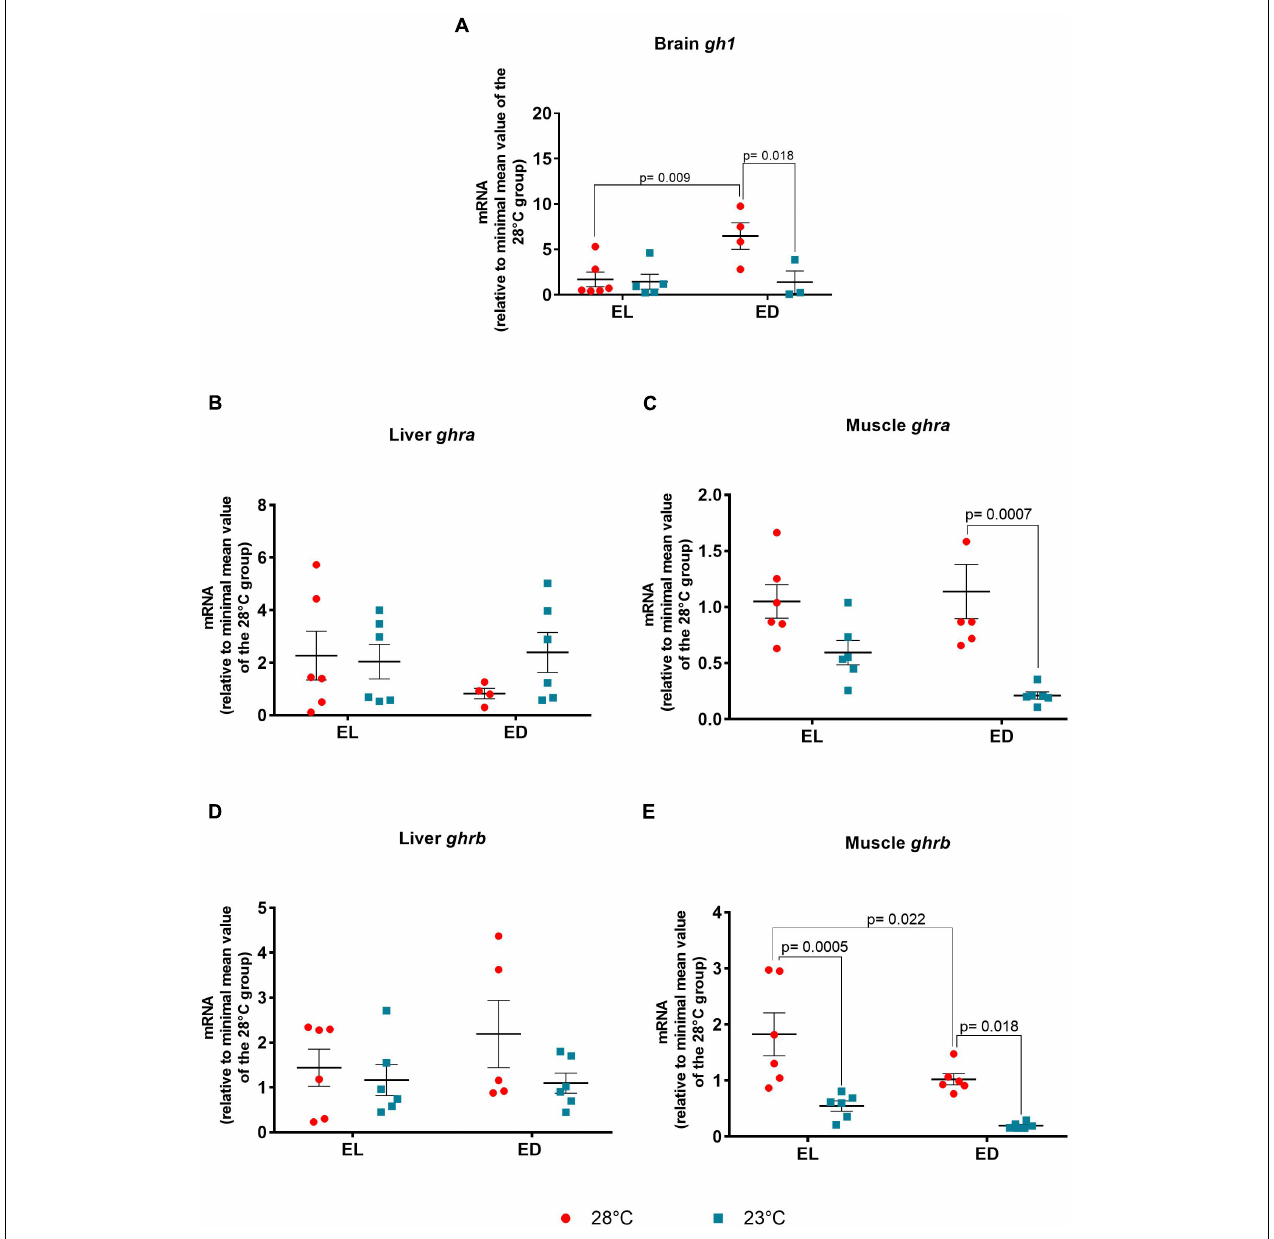
FIGURE 2 | Early light (EL) and early dark (ED) gene expression of growth hormone ( gh1 ) and growth hormone receptors ( ghra and ghrb ) in adult Danio rerio . (A) Brain gh1 ; (B) liver ghra ; (C) muscle ghra ; (D) liver ghrb ; (E) muscle ghrb . The gene expression was normalized by the 18S rRNA and expressed relative to the lowest mean of the control temperature group. The values are expressed as mean ± SEM. n = 3–6 (pools of four animals each). Significant differences are shown when p < 0.05. Red symbol corresponds to 28 o C and blue symbol corresponds to 23 o